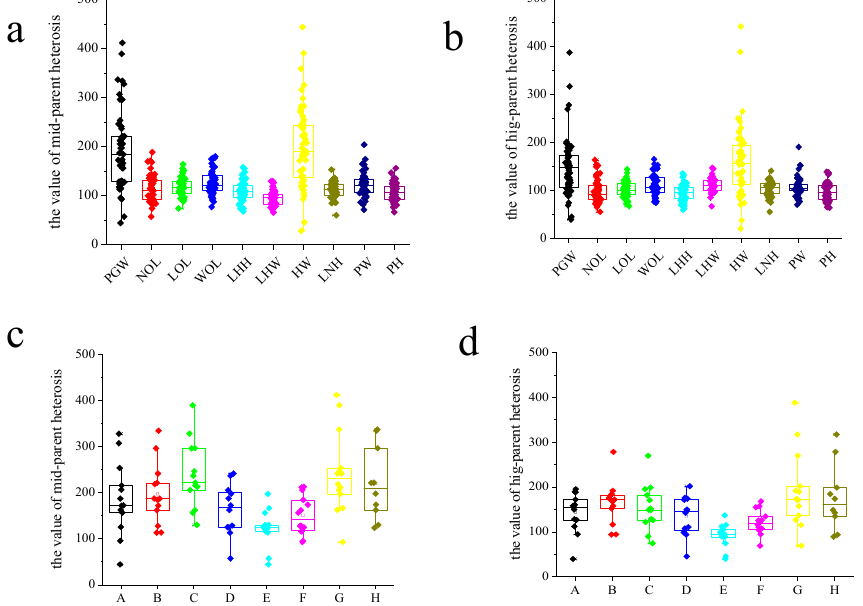
Figure 1. The mid-parent heterosis value and high-parent heterosis value in hybrids. ( a ) The mid-parent heterosis value of different traits in 53 hybrids. ( b ) The high-parent heterosis value of different traits in 53 hybrids. ( c ) The mid-parent heterosis value of plant growth weight with different parents. ( d ) The high-parent heterosis value of plant growth weight with different parents. PGWplant growthth weight, NOL: number of outer leaves, LOL: length of the biggest outer leaf, WOL: width of the biggest outer leaf, LHH: leaf head height, LHW: leaf head width, HW: head weight, LNH: leaf number of head, PW: